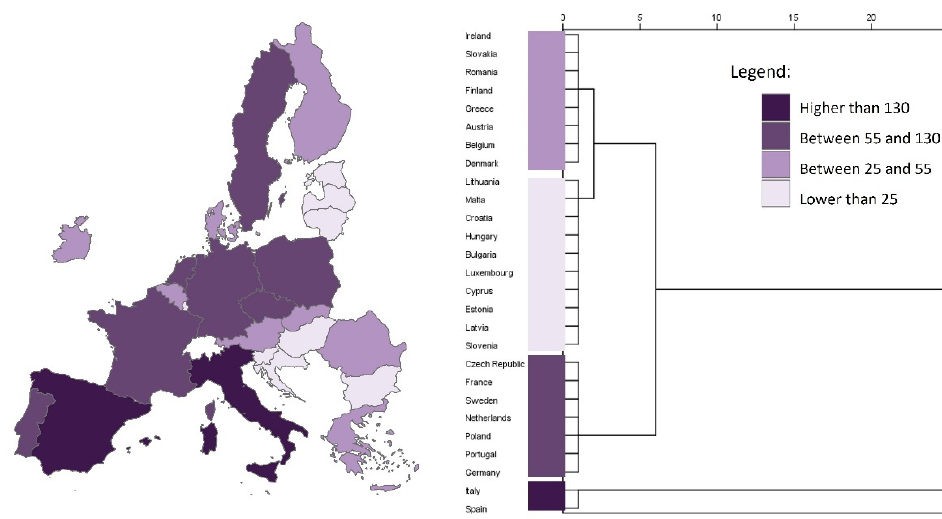
Figure 5. Clusters of the countries by their number of literature results.